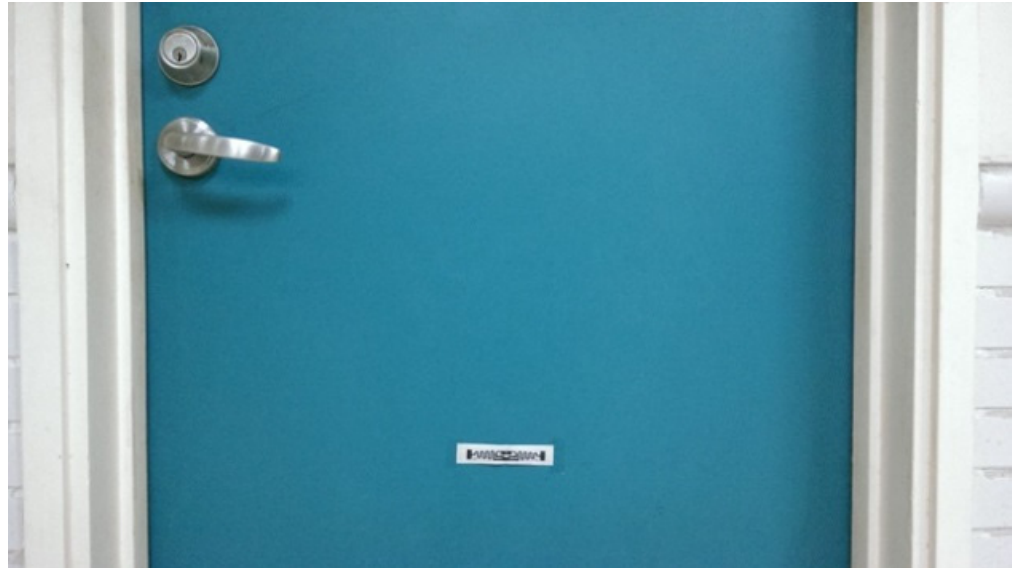
Figure 20. Tag posted on the door.